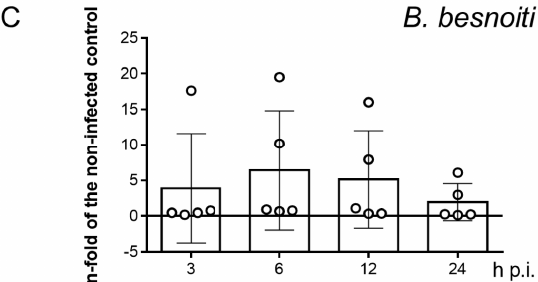
Figure 7. SR-BI gene transcription in T. gondii- ( A ), N. caninum- ( B ) and B. besnoiti- infected ( C ) primary bovine umbilical vein endothelial cells (BUVEC). Bars represent the means of five biological replicates ± standard deviation. Significant level p <